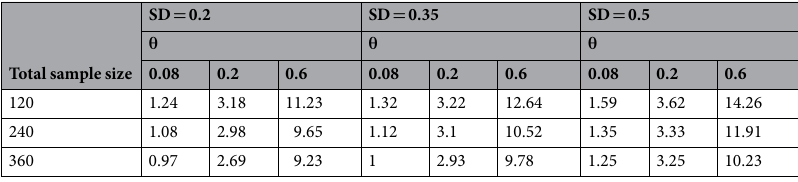
Table 4. Averaged of mean squared error (E-03) of the best tree. The complexity table of Gibbs-RPart on Parkinson’s disease data. The red row (row 4) indicates the best size tree with 6 terminal